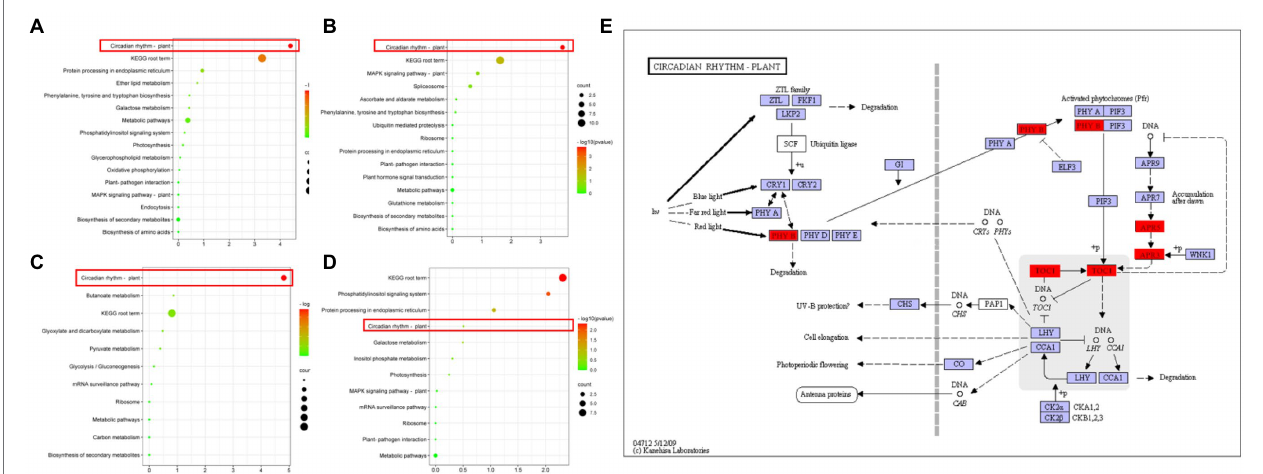
FIGURE 7 | KEGG enrichment of combined consistent QTL and transcriptome analysis of intersecting genes. (A) KEGG enrichment of genes that intersect with the transcriptome of the consistent QTL region and the 5-leaf stage leaves. (B) KEGG enrichment that intersects with the transcriptome of the consistent QTL region and the 6-leaf stage leaves. (C) KEGG enrichment of genes that intersect with the transcriptome of the consistent QTL region and the 5-leaf stage SAMs. (D) KEGG enrichment of genes that intersect with the transcriptome of the consistent QTL region and the 6-leaf stage SAMs. (E) Plant circadian rhythm pathway. The positions marked in red are candidate genes (Kanehisa and Goto, 2000; Kanehisa, 2019; Kanehisa et al.,